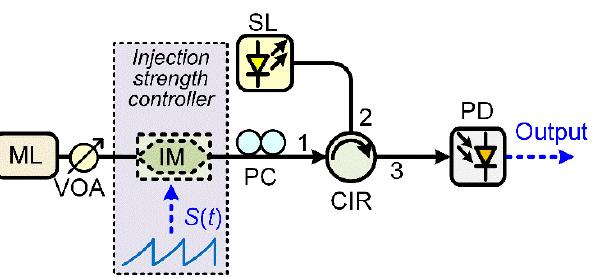
Figure 9. Schematic diagram of the LFM waveform generator. IM: intensity modulator.